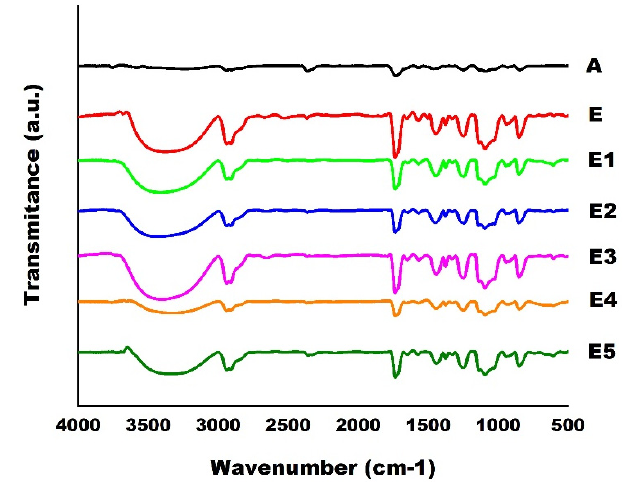
Figure 8. FTIR spectra of as–received PVA and milled powder samples by mechanical alloying with and without Ag in several studied conditions. (A) as–received PVA; (E) Pure PVA milled for 4 h; (E1) PVA + 0.5% wt. Ag milled for 4 h; (E2) PVA + 1% wt. Ag milled for 4 h; (E3) PVA + 2.5% wt. Ag milled for 4 h; (E4) PVA + 5% wt. Ag milled for 4 h; and (E5) PVA + 10% wt. Ag milled for 4 h.